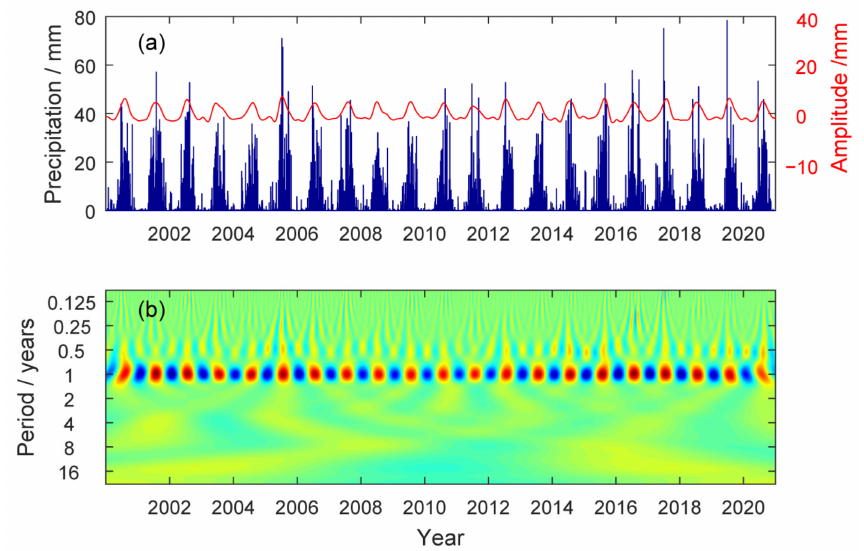
Figure 5. Time series analysis of precipitation at SCPZ station. ( a ) The blue histogram is the daily average of precipitation and the red line is the extracted seasonal term. ( b ) Morlet wavelet transform, where red means peak and blue means trough.